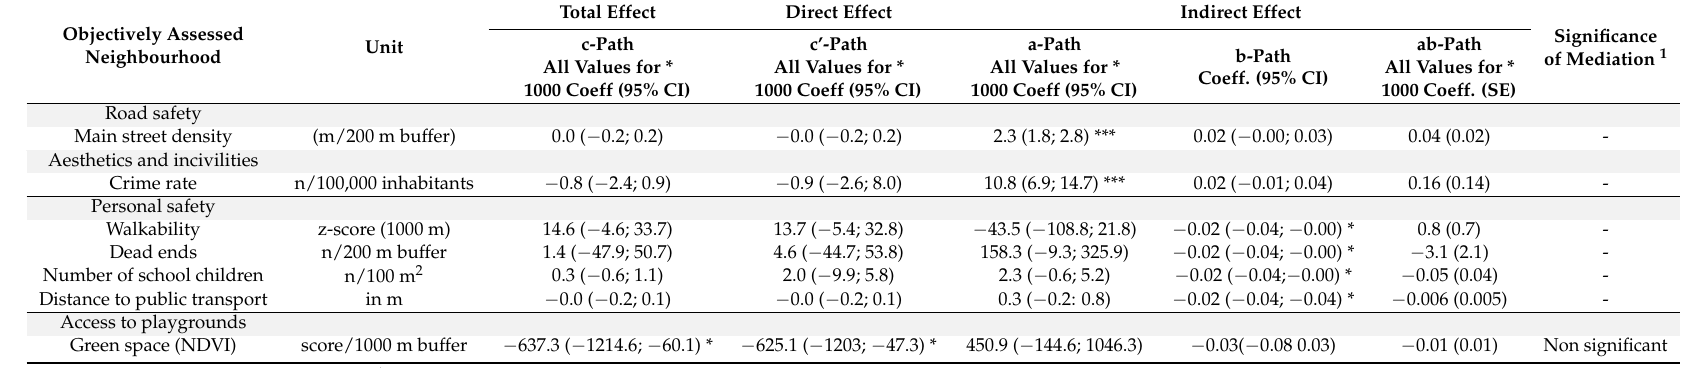
Table 3. Mediation of the associations between the objectively assessed environment and children’s sedentary time on weekdays by the perceived